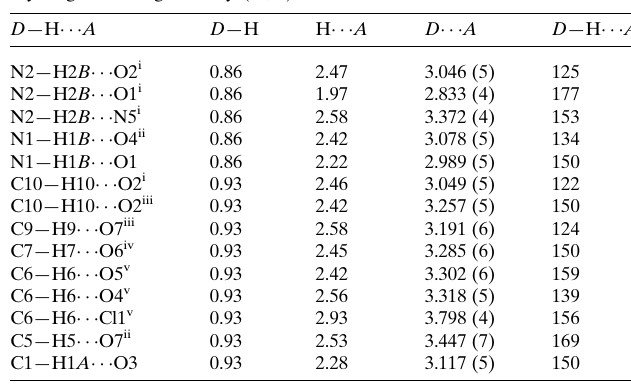
Table 1 Hydrogen-bond geometry (A˚ , (cid:4) ).